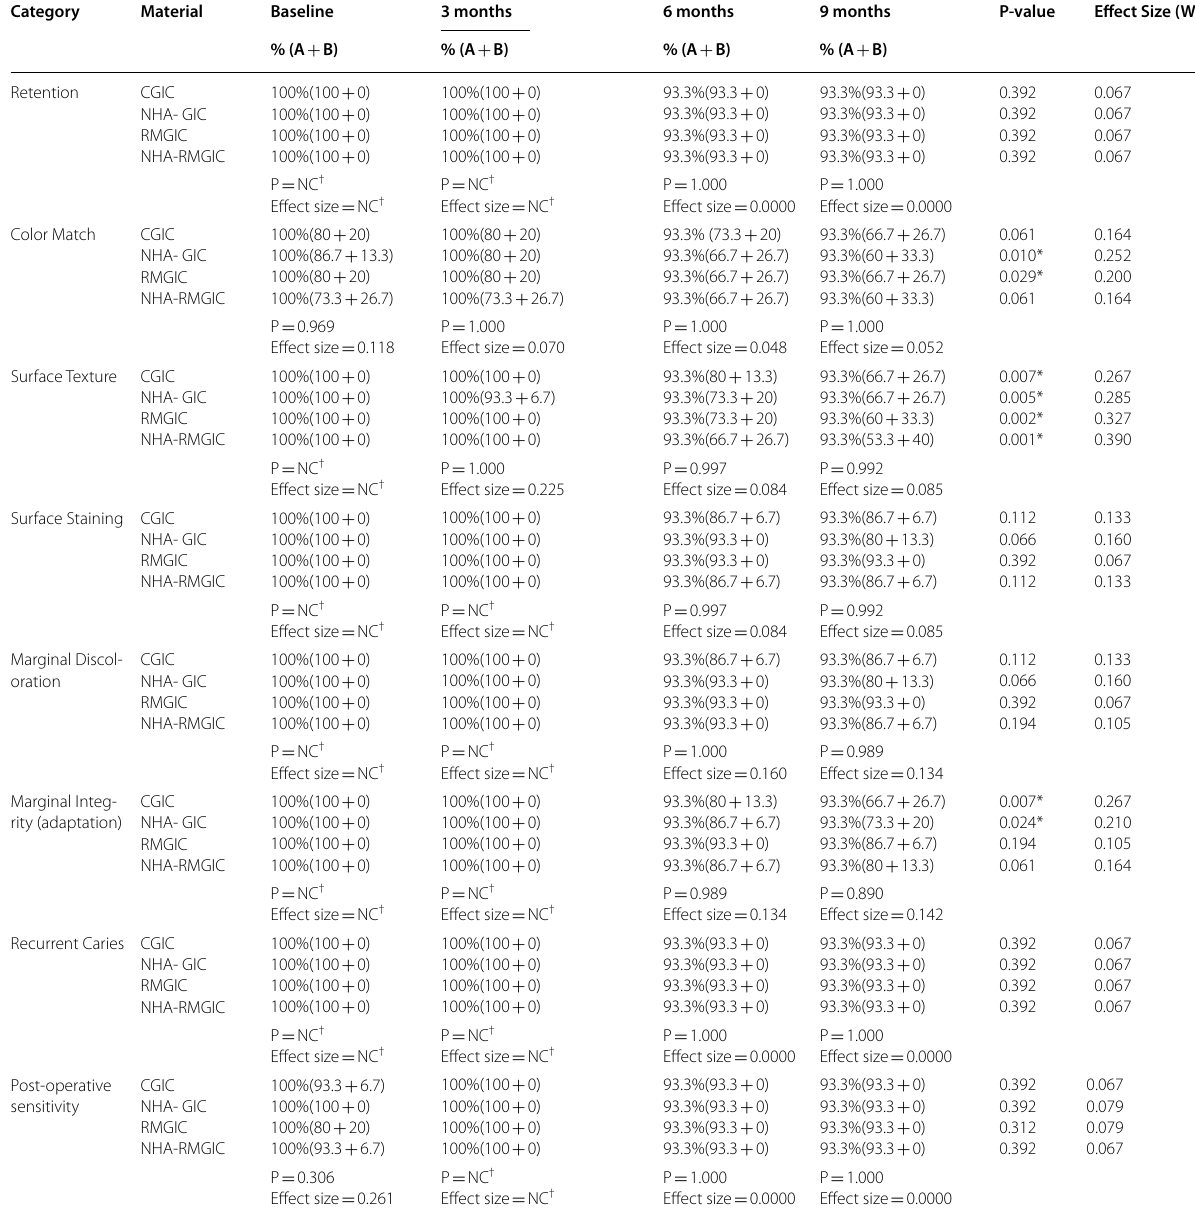
Table 5 Descriptive statistics and results of Fisher’s Exact test for comparison between the four